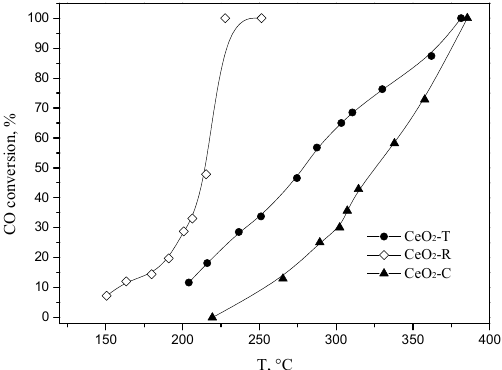
Figure 4. Catalytic activity of CeO 2 with different morphologies in CO oxidation.